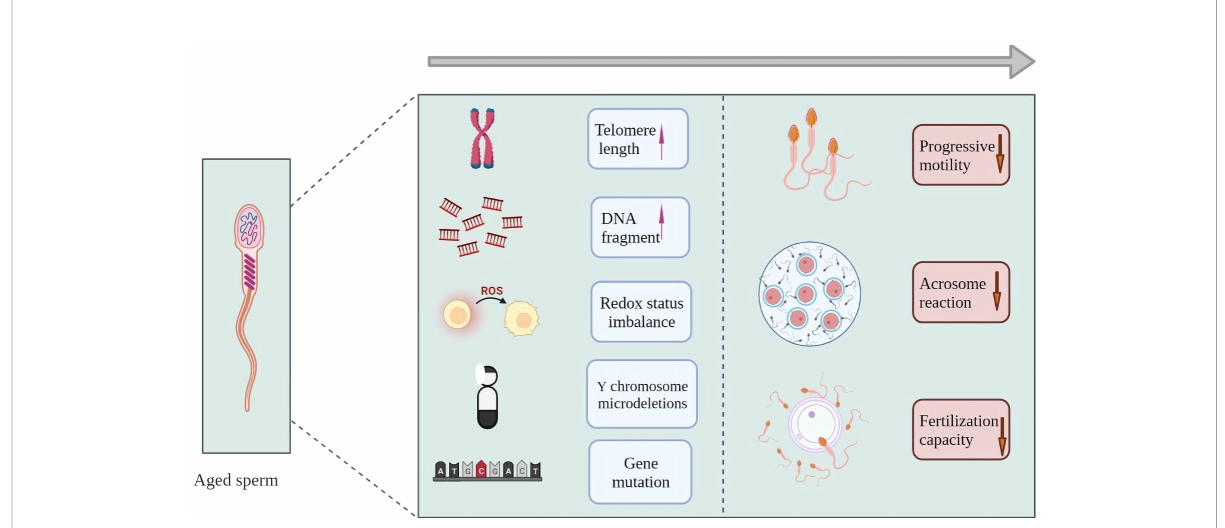
FIGURE 2 Aging and sperm. In mechanism, aging sperm shows growing telomere length, increased DNA fragmentation, redox imbalance and so on. Eventually in the phenotype, sperm showed abnormal acrosome reaction, decreased fertilization ability and other